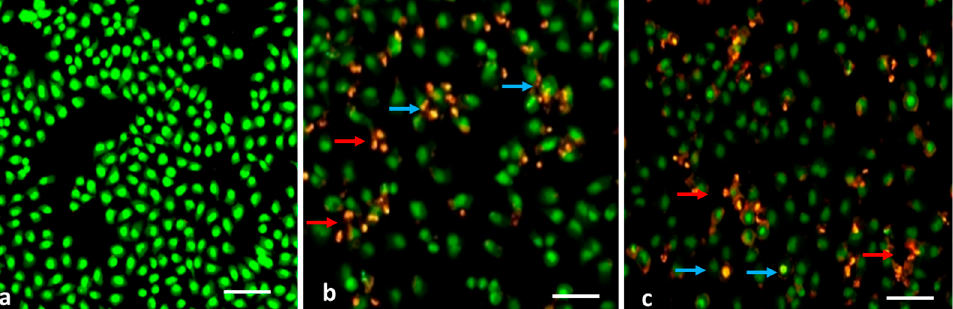
Figure 6. MDA-MB-231 cells exhibit apoptotic cell death induced by MgO-Chitosan-Pluronic F127- Escin NPs. MDA-MB-231 cell lines of breast cancer were treated with MgO-Chitosan-Pluronic F127- Escin NPs for 24 h. Acridine orange and ethidium bromide (1:1) was used to stain the cells, and representative stained cells from each group were shown. Control ( a ), 10 µg/mL of MgO-Chitosan- Pluronic F127-Escin NPs-treated cells ( b ) and 20 µg/mL of MgO-Chitosan-Pluronic F127-Escin NPs- treated cells ( c ). Green color cells indicate normal cells, yellowish green cells indicate early apoptosis (Blue arrow), yellow color cells indicate late apoptotic cell death (red arrow), and red cells indicate necrotic cell death (scale bar 50 µm). 20X magnification was used to capture the images.